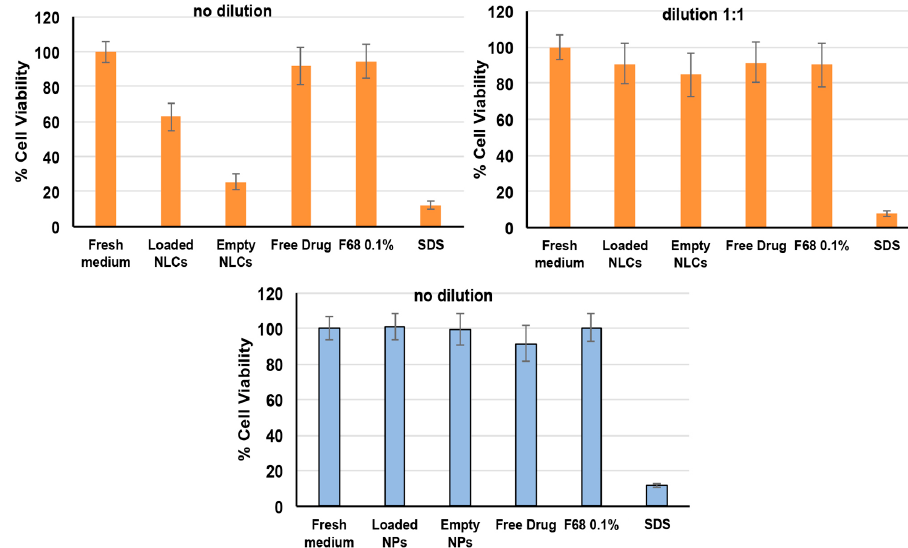
Figure 5. The percent cell viability of Caco-2 cell line measured by MTT test after 24 h incubation with empty and CEF-loaded NLCs (orange bars) or CS NPs (blue bars) and their components. Fresh culture medium and SDS (1 mg/mL) were used as negative and positive control, respectively (mean ± SD, 4 replicates per plate in 3 independent plates).